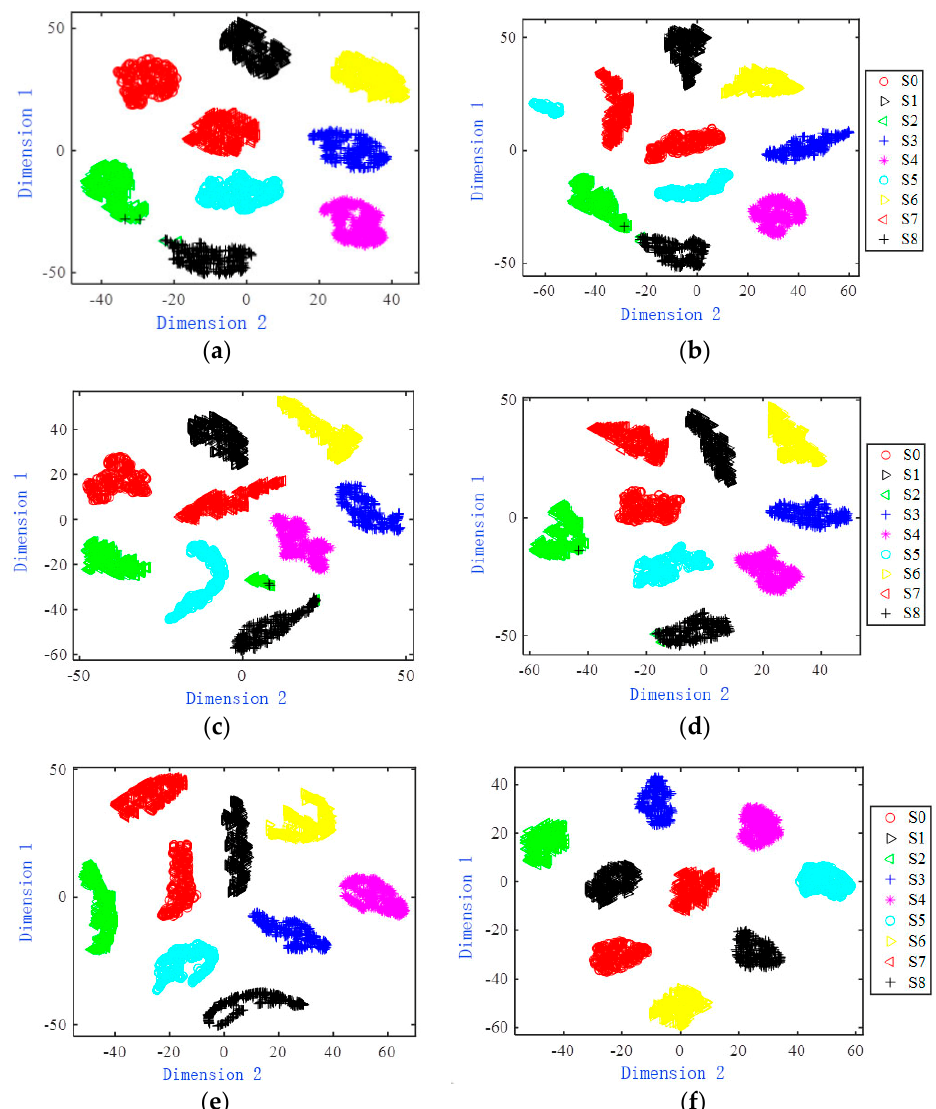
Figure 7. Two-dimensional scatter distribution of original data and features extracted from each network model in the Shallen–Key bandpass filter circuit formed by T-SNE method. ( a ) Circuit fault data. ( b ) Features extracted by the BPNN network. ( c ) Features extracted by the RNN network. ( d ) Features extracted by the LSTM network. ( e ) Features extracted by the 1DCNN network. ( f ) Features extracted by the MSCNN-SK network.